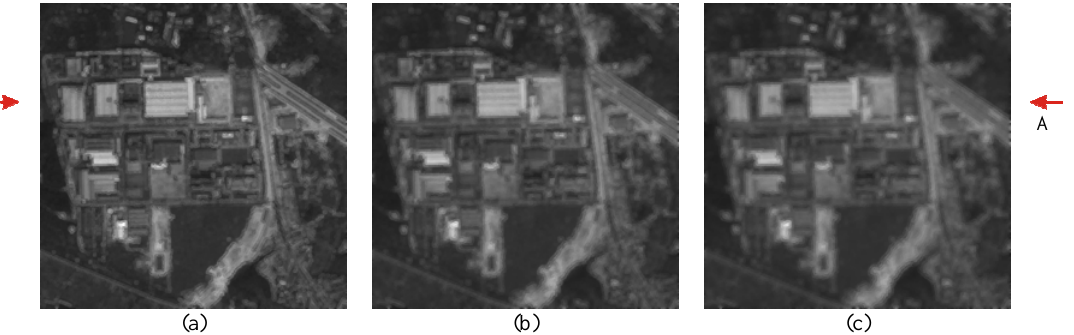
Figure 6. Resulting images after different times of edge protection smoothing: (a) one time; (b) twice; (c) three